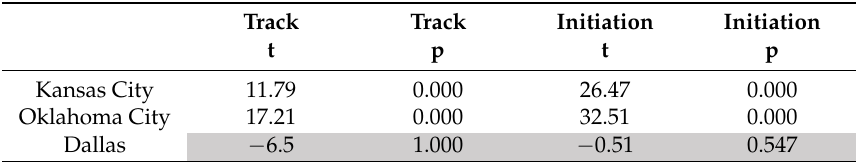
Table 2. T-test to examine differences in the means of thunderstorm tracks (km) and initiation (count) between urban and rural areas of three cities. Not significant is shaded